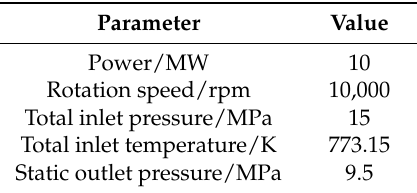
Table 1. Initial design